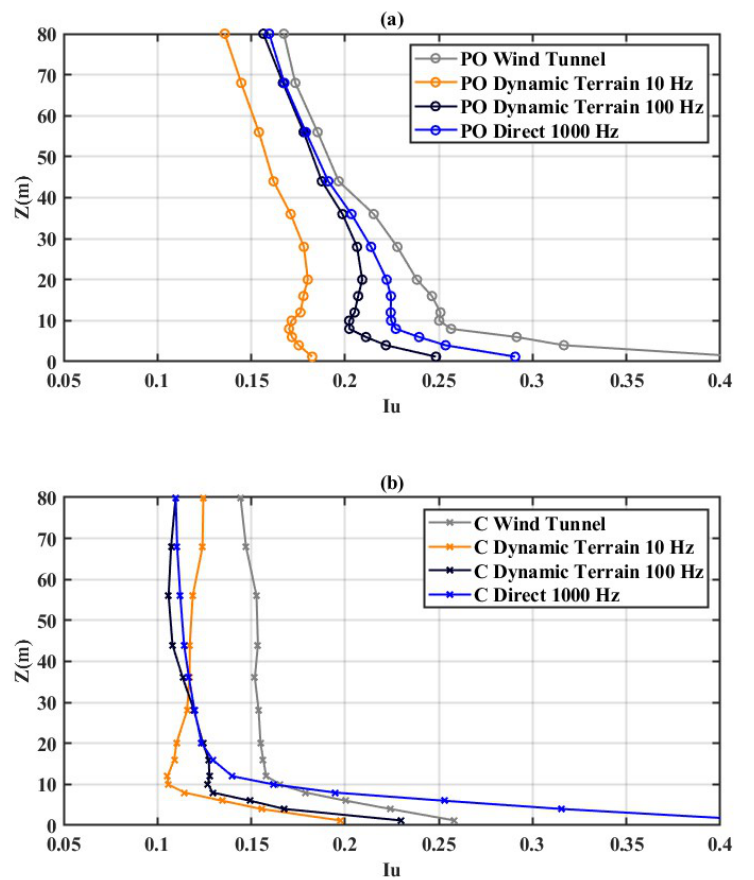
Figure 10. Turbulence intensity at ( a ) PO and ( b ) C as extracted from wind tunnel and calculated from dynamic terrain 10 Hz, dynamic terrain 100 Hz, and direct